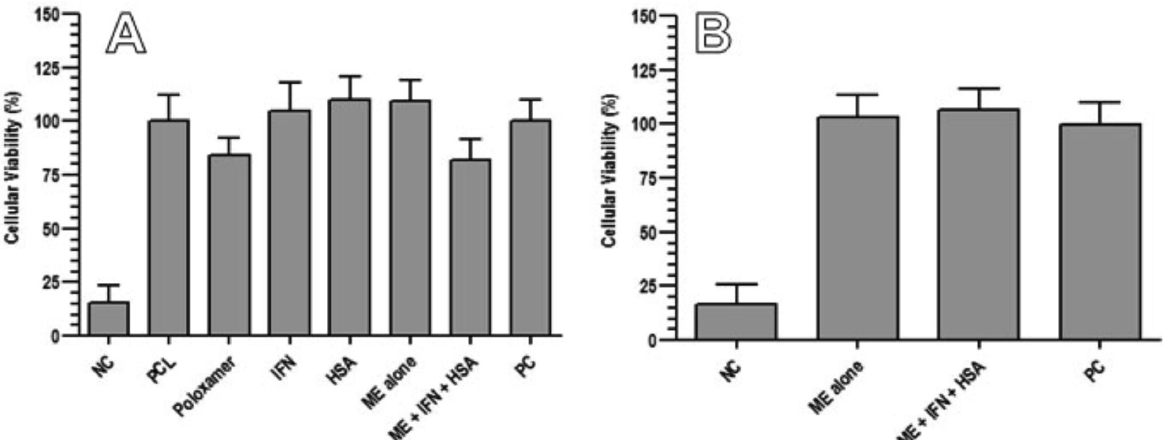
FIGURE 3 – Percentage of hepatic cell line viability after: A – application of developed microspheres and all their components; and B – application of microsphere degradation products. NC: negative control; PCL: poly-ε-caprolactone; IFN: interferon-alpha; HSA: human serum albumin; ME alone: microspheres without protein; ME + IFN + HSA: microspheres containing interferon- alpha and human serum albumin; PC: positive control (Values are shown as mean ± standard deviation, n =